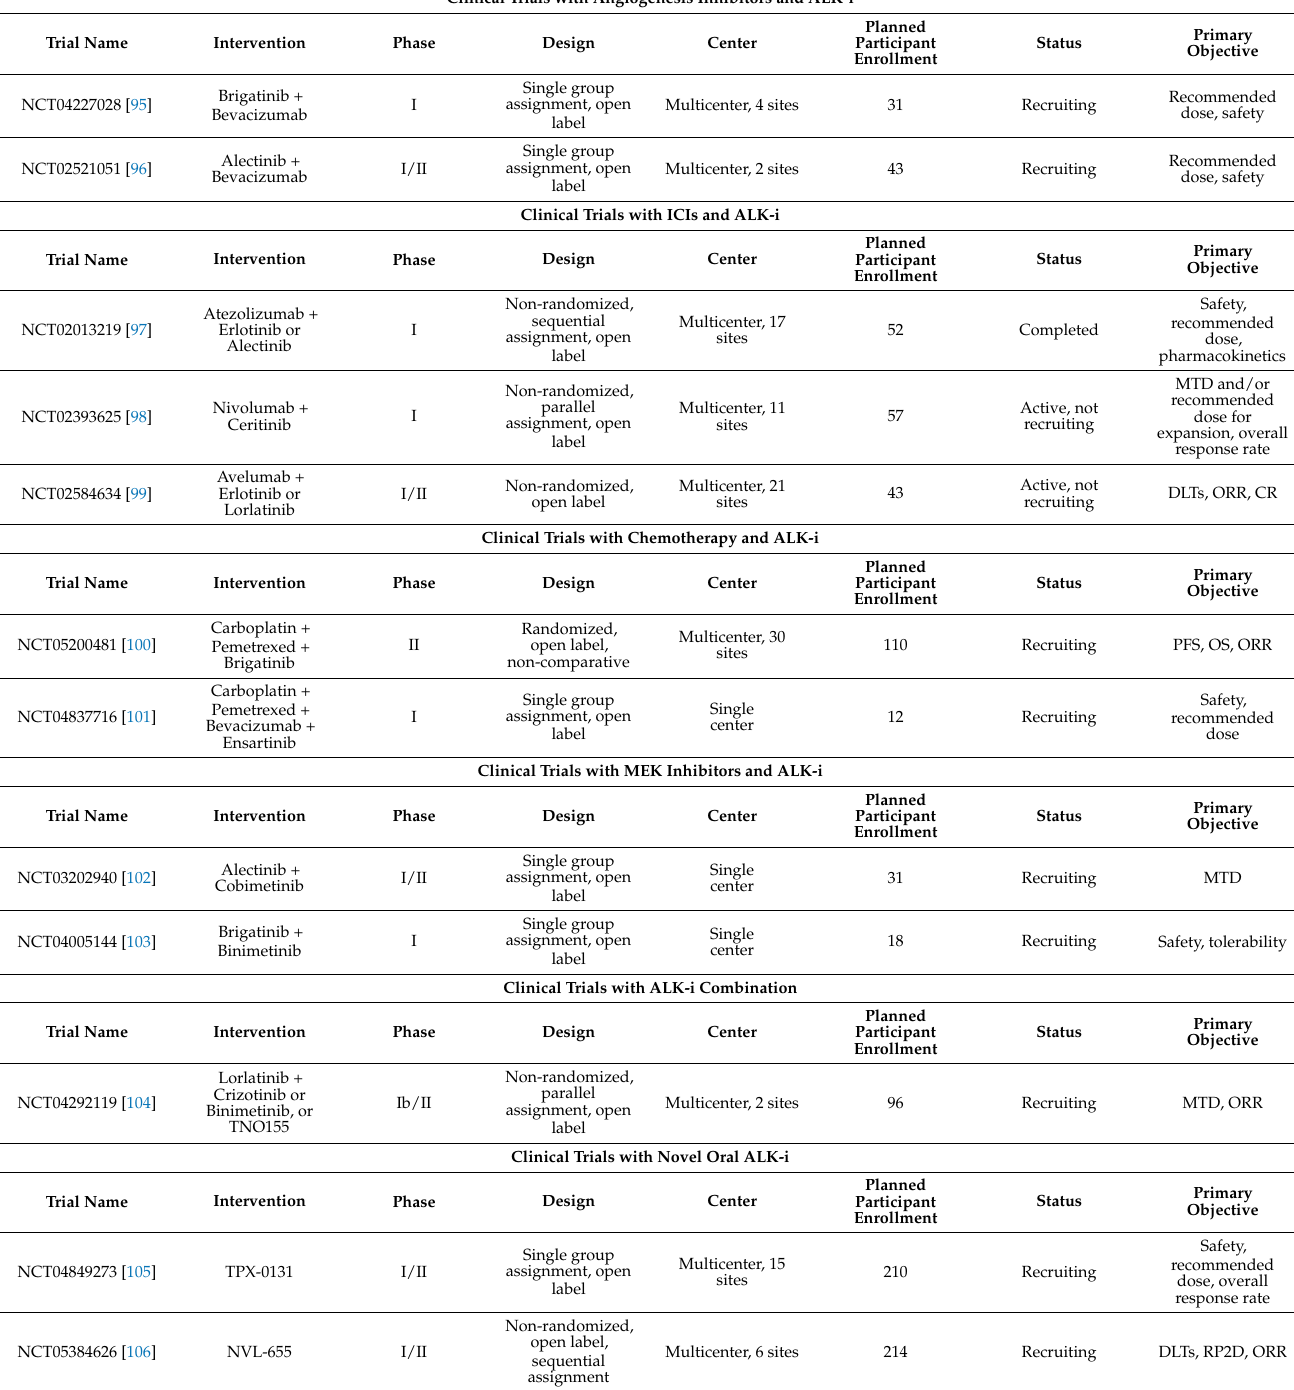
Table 1. Ongoing clinical trials, including ALK-i in combination with angiogenesis inhibitors, ICIs, chemotherapy or MEK inhibitors and novel oral